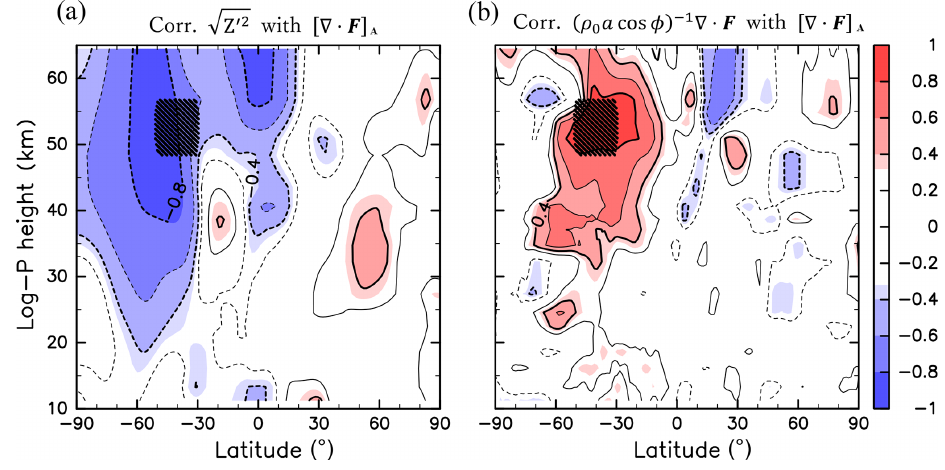
(cid:113) Z (cid:48) 2 and (b) (ρ 0 a cos φ) − 1 ∇· F for JJA of 1980–2017.